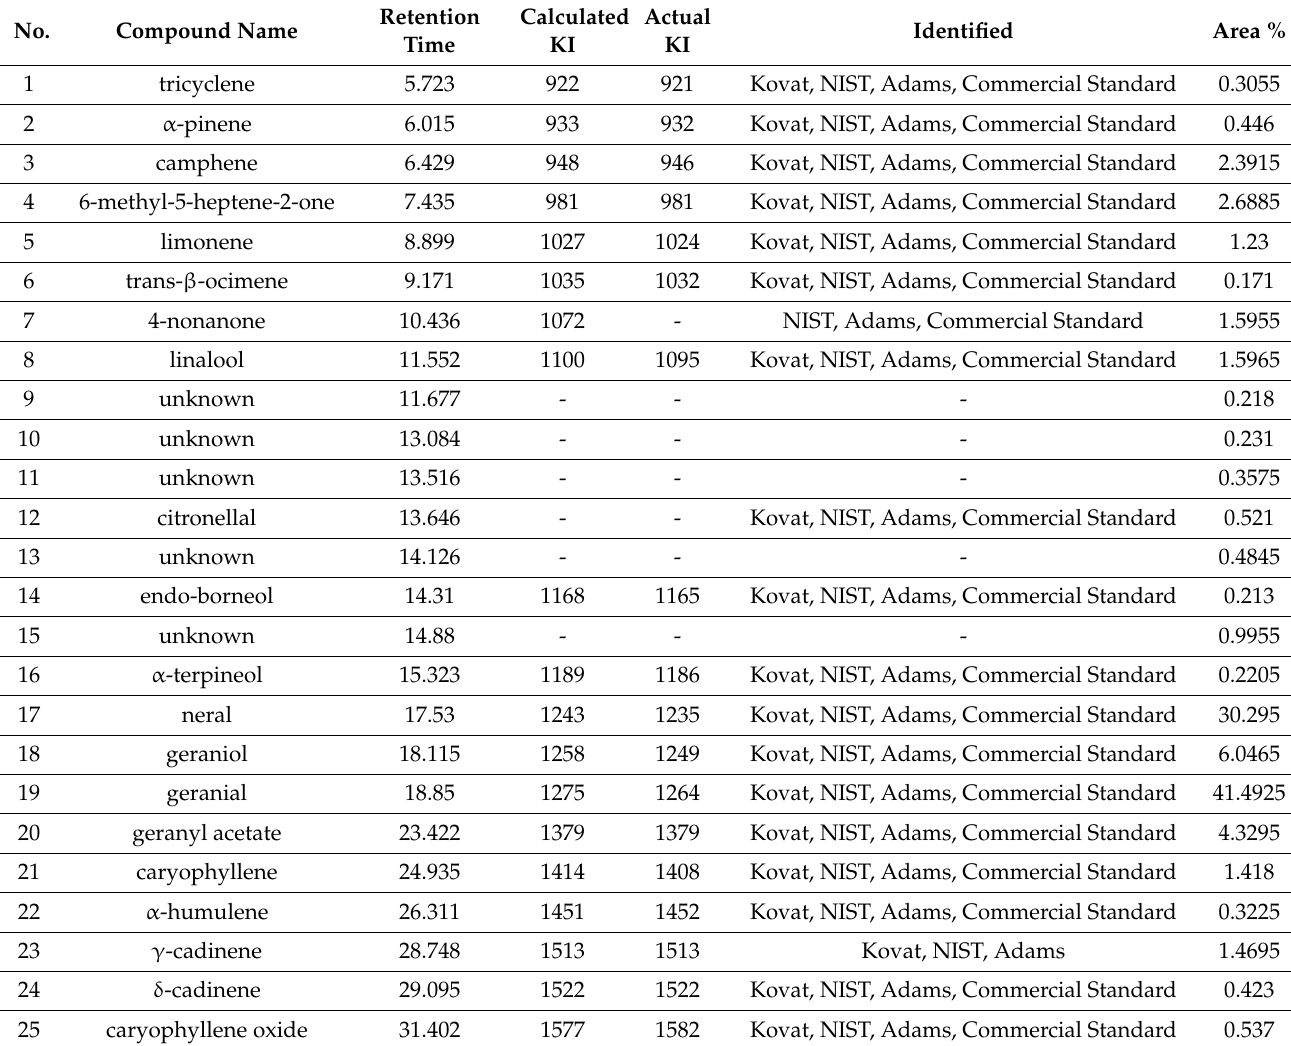
Table 6. Cymbopogon citratus essential oil (EO) constituents identified via GC–MS–FID